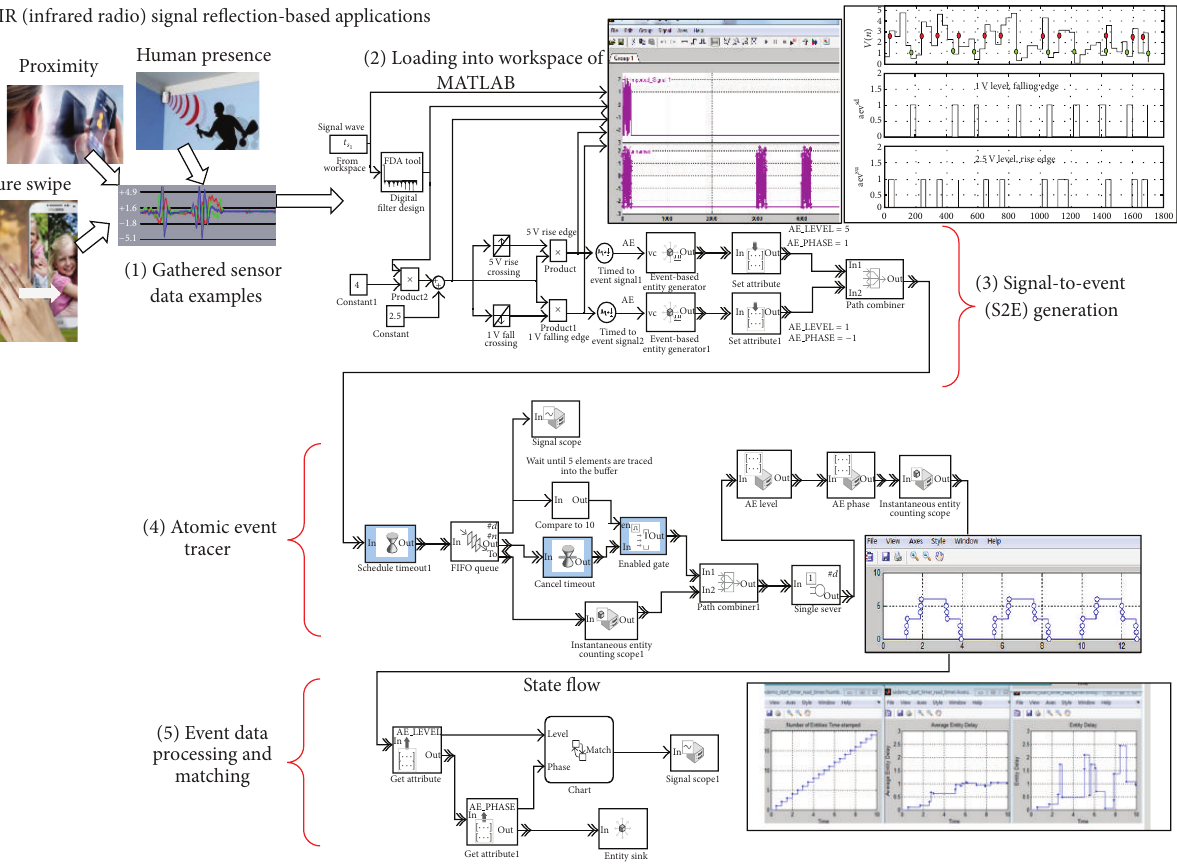
Figure 10: Experimental design and measurement of the implementation